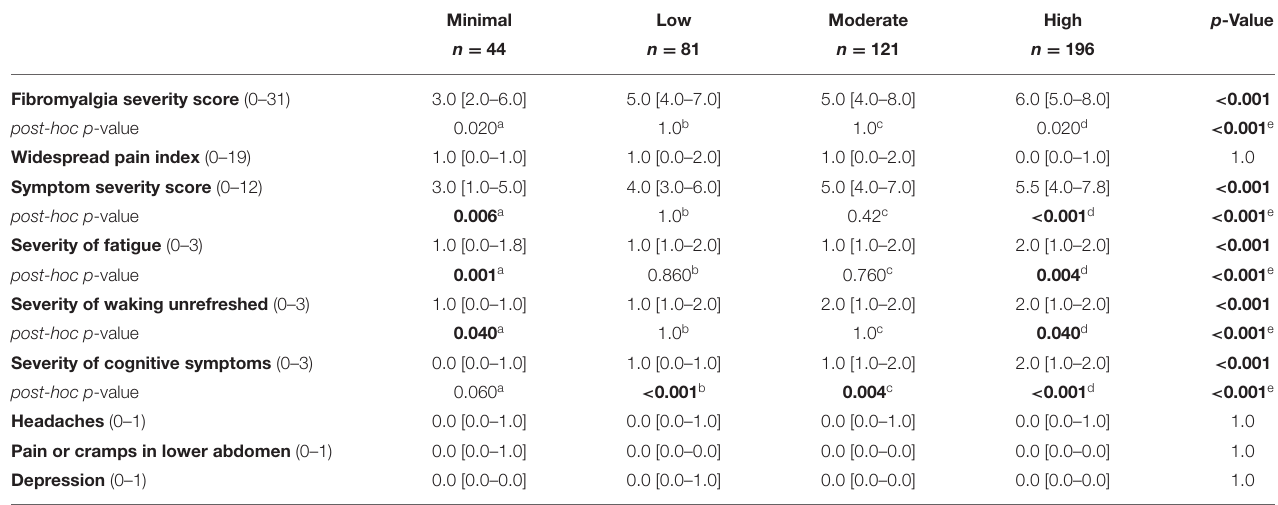
TABLE 3 | Nociplastic pain indicators compared between groups stratified by levels of kinesiophobia on the TSK-11 score as Minimal (TSK ≤ 22), Low (TSK 23–28), Moderate (TSK 29–35), and High (TSK ≥ 36). Minimal